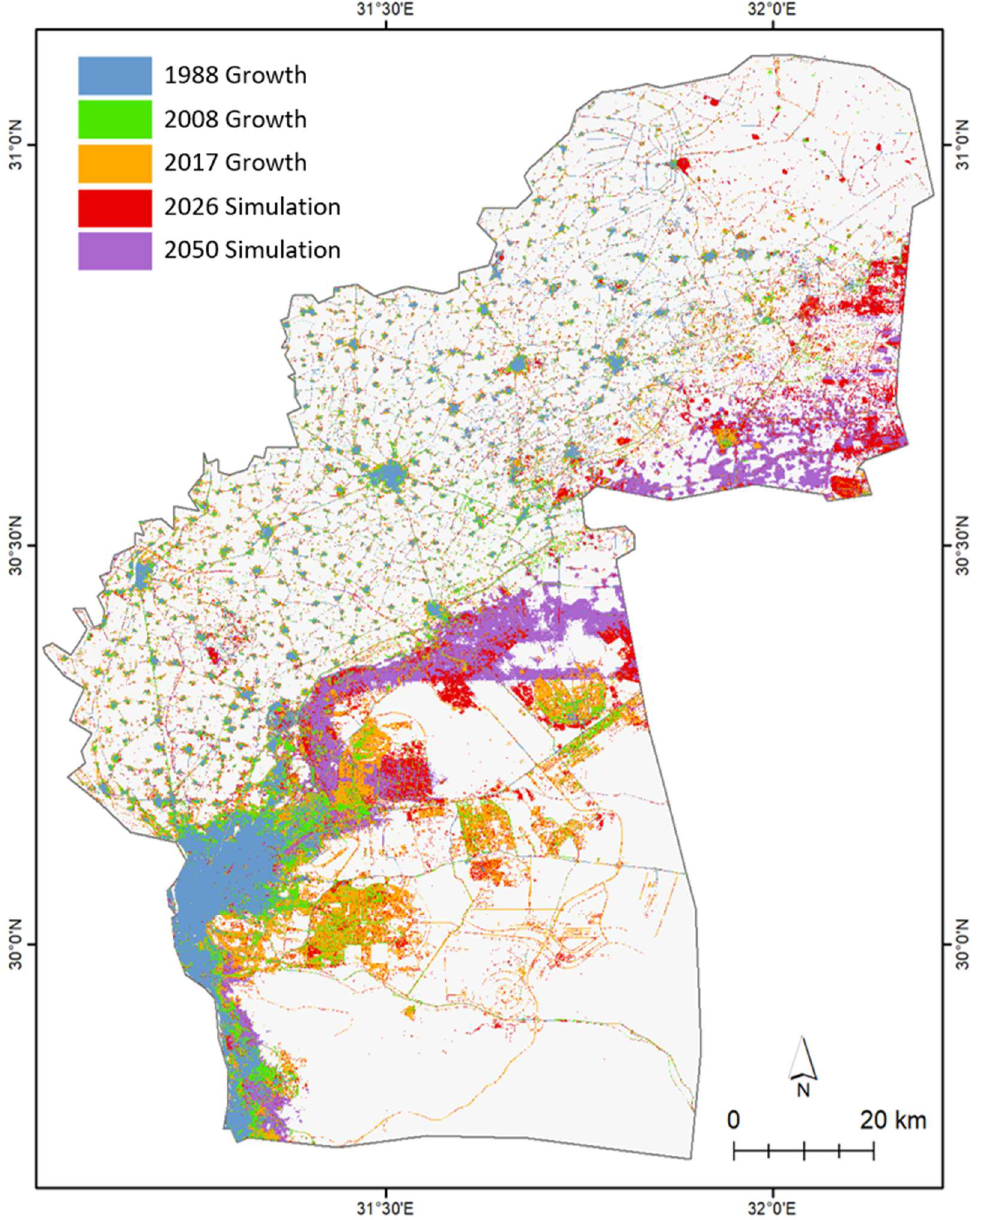
Figure 8. Actual urban growth (1988, 2008 and 2017) and simulated urban growth (2026 and 2050) are modeled within a subset of the ND. It is evident that urban areas are growing, with most of the urban growth concentrated in the desert flank of the ND.